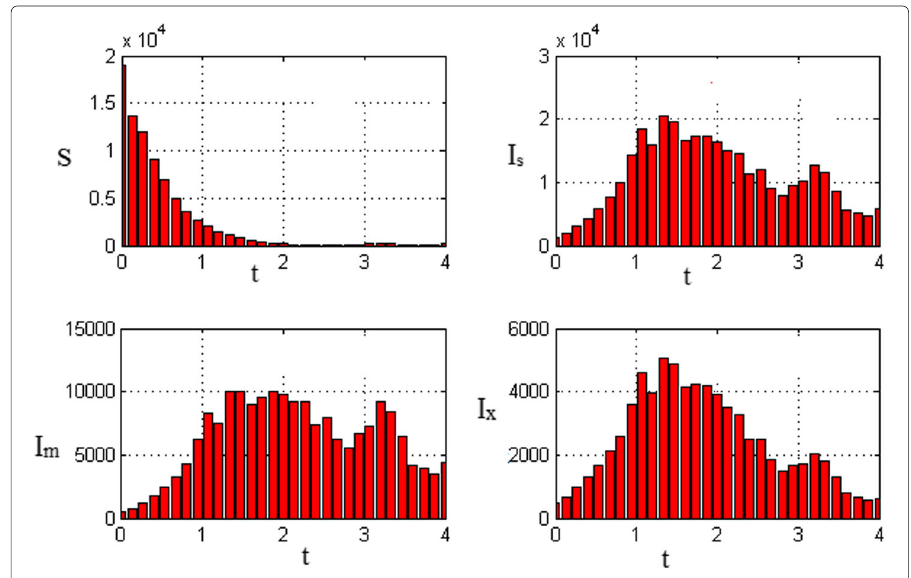
Fig. 8 The approximate solutions with θ = 0.35, ξ = 0.5, h = 4